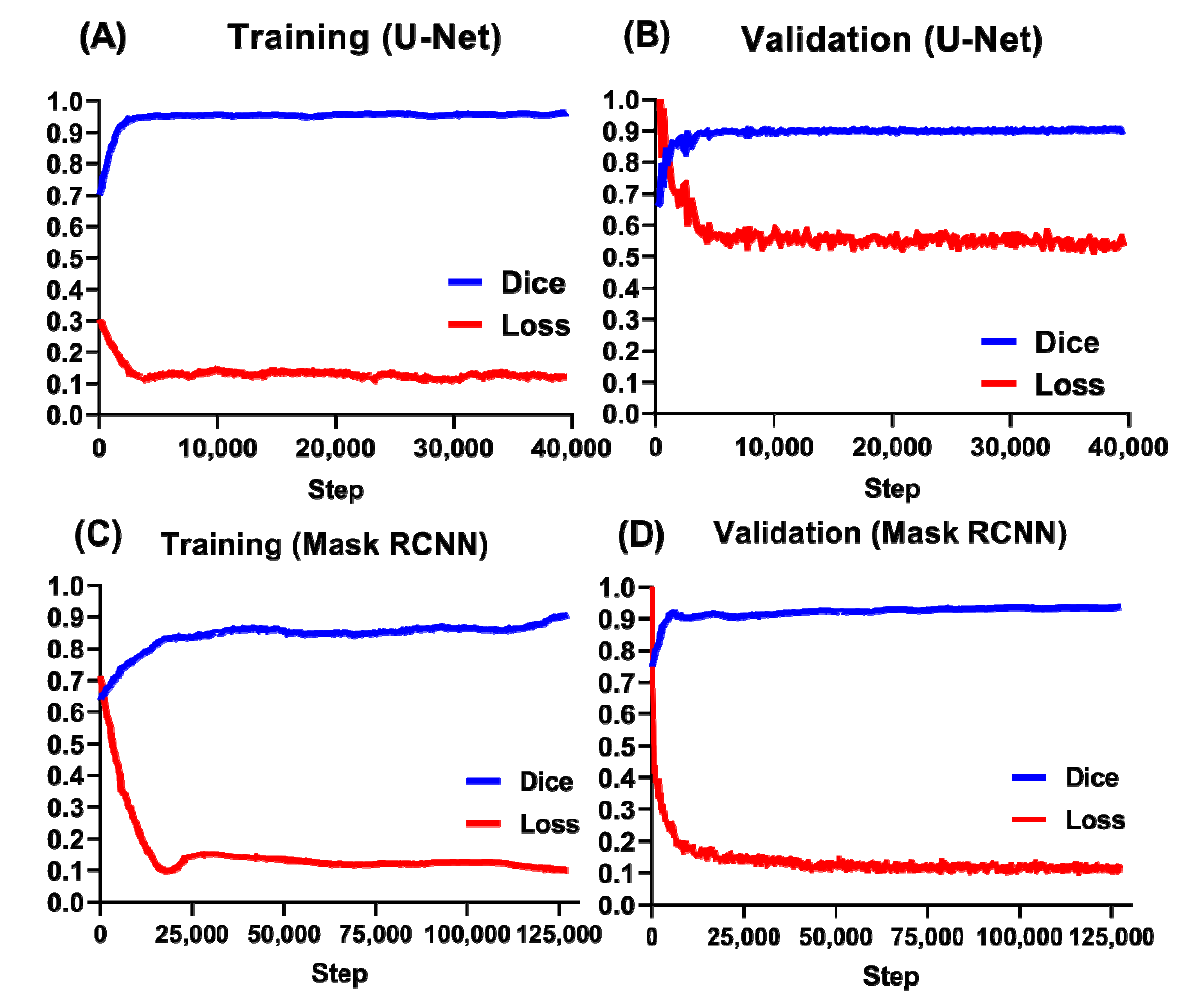
Figure 2. The Dice and loss curves for the U-net and Mask RCNN method for D. magna heart size prediction. The Dice and loss curve for the U-Net method at either training ( A ) or validation ( B ) process. The Dice and loss curve for the Mask RCNN method at either training ( C ) or validation ( D ) process.